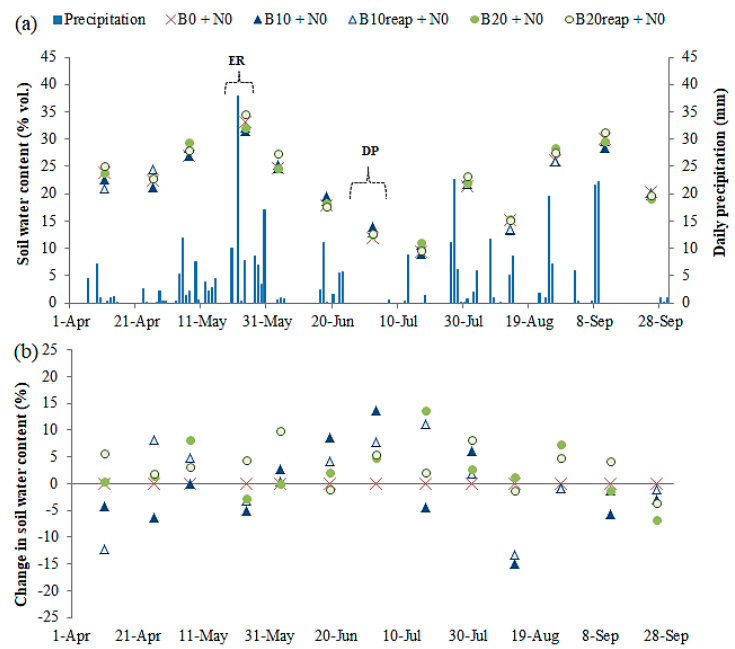
Figure 2. Soil water content dynamics in unfertilized treatments during the studied period in 2019: ( a ) soil water content with indication of daily precipitation, ER—extreme rainfall, DP—dry period; ( b ) percentage change in soil water content relative to control treatment B0 + N0 (without biochar and N-fertilizer application).